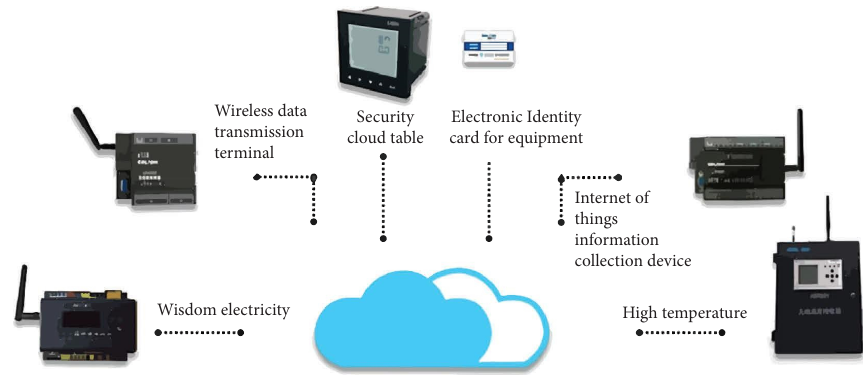
Figure 1: Intelligent power